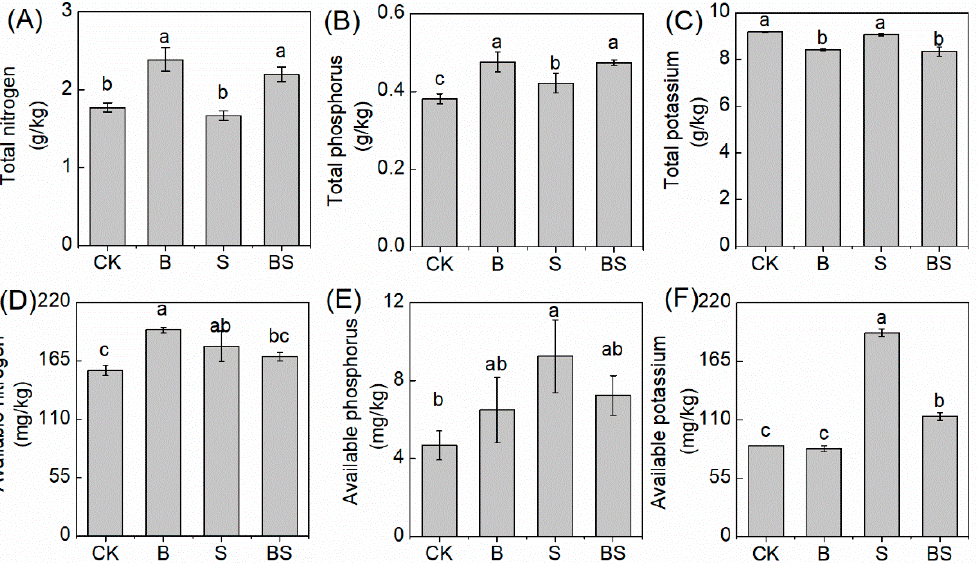
Figure 2. The total nitrogen ( A ), total phosphorus ( B ), total potassium ( C ), available nitrogen ( D ), available phosphorus ( E ), and available potassium ( F ) content in the soil under treatments. Columns with different letters are significantly different at P < 0.05. CK: organic substitution; B: organic substitution + biochar; S: CK + NaCl; BS: B + NaCl.